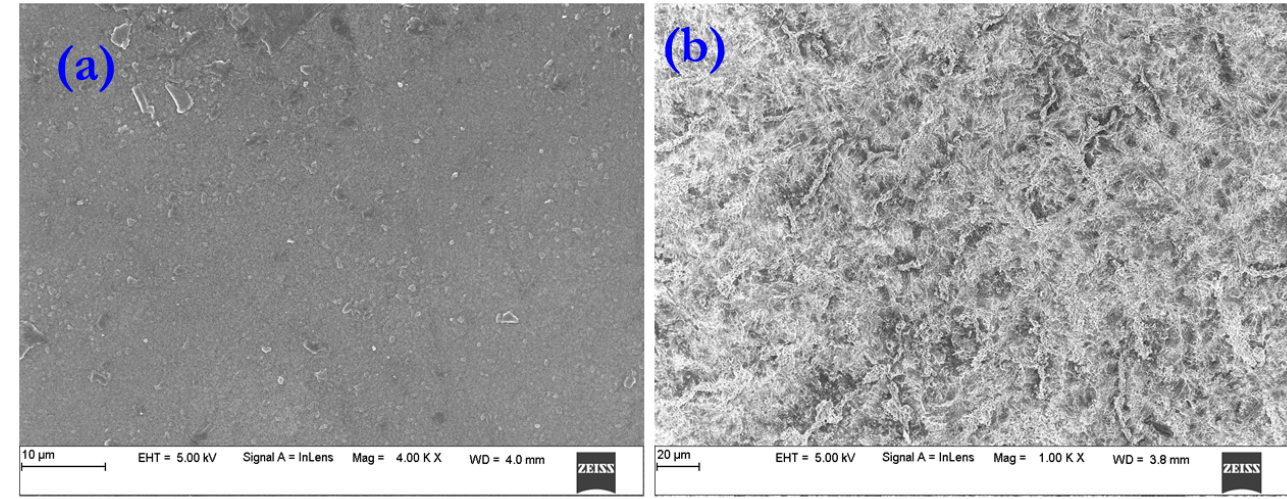
Figure 4. SEM images of ( a ) Plain PVA membrane and ( b ) PVA-g-St-g-PMA membrane.